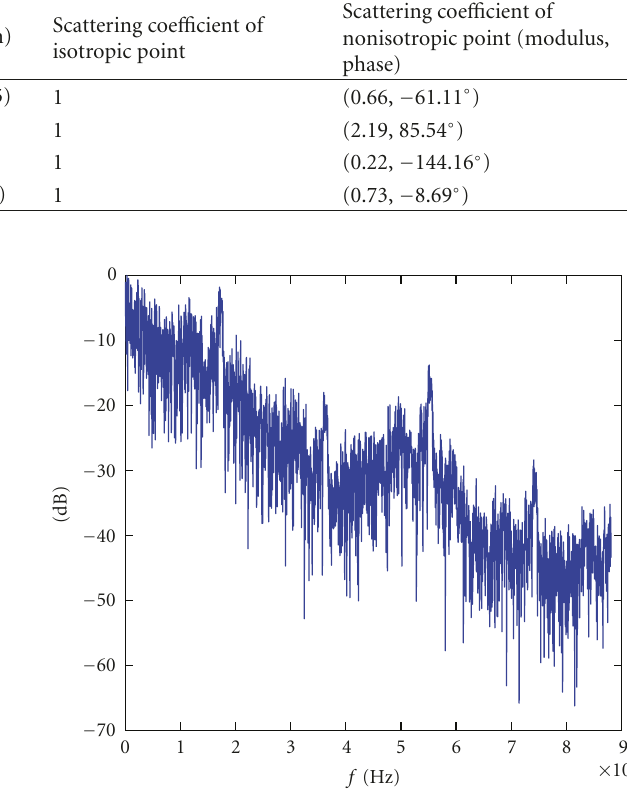
Figure 6: Example of baseband transmitted signal